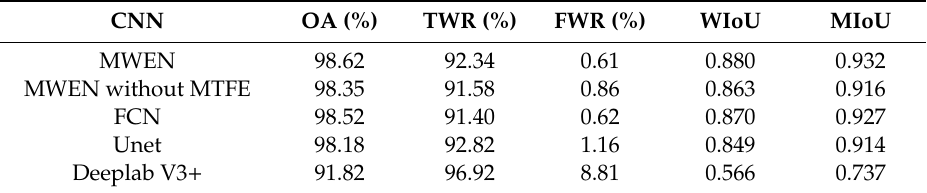
Table 5. Water body extraction accuracies of the various